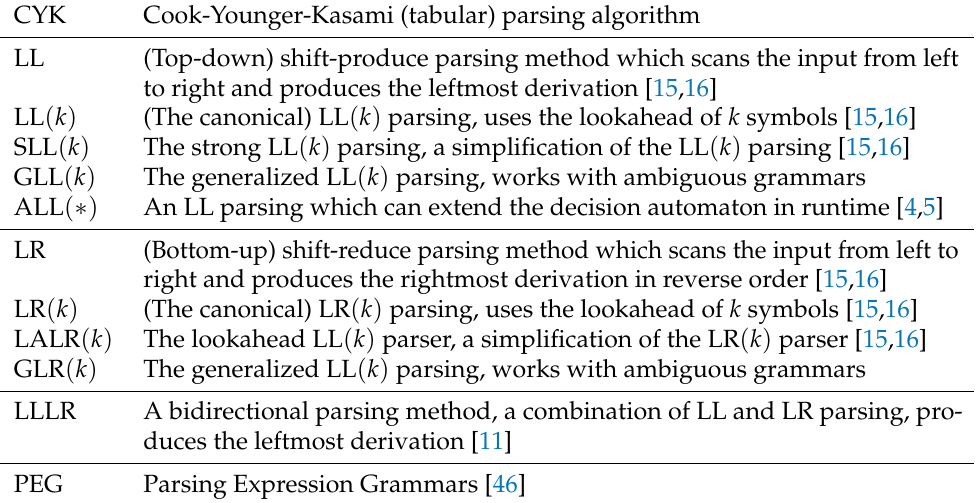
Table A1. List of